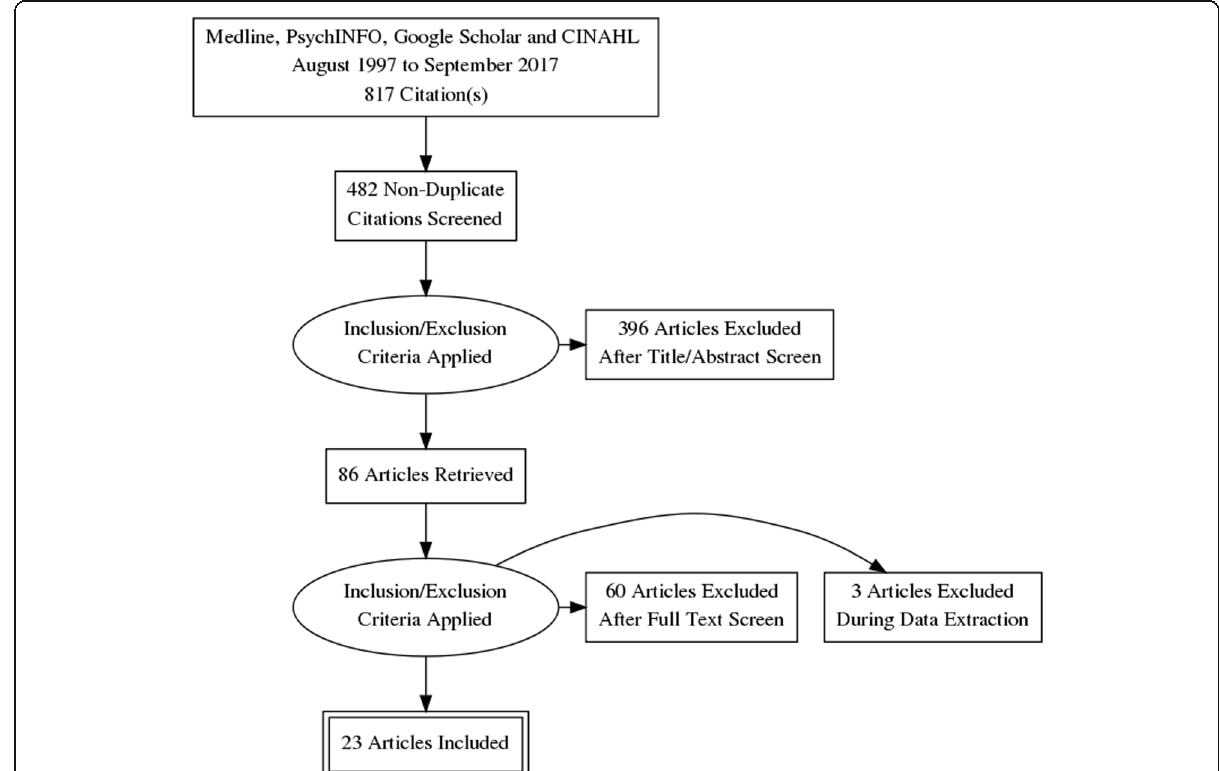
Fig. 1 PRISMA flow